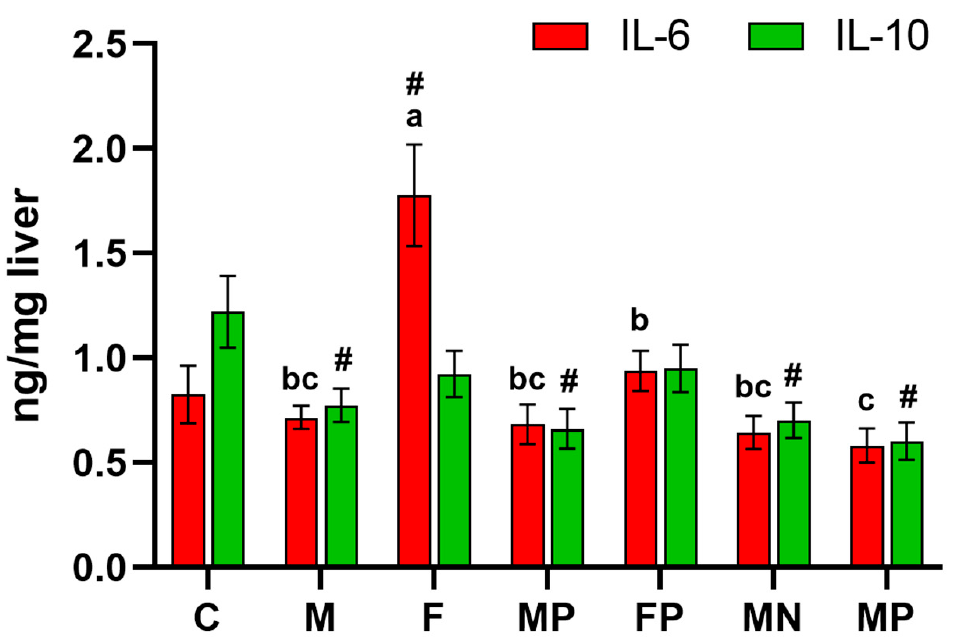
Figure 1. Inflammatory cytokines in the liver of rats fed the experimental diets ( n = 12 per group). a–c Mean values with unlike superscript letters are shown to be significantly different ( p < 0.05) in regard to the experimental groups M, F, MP, FP, MP, MN. Additionally, each experimental group was compared with the control C group using t -test (# indicates a significant difference versus the C group). IL-6, interleukin 6; IL-10, interleukin 10. Table 4. Blood plasma parameters in rats fed experimental diets ( n = 12 per group) Table 3. Hepatic mRNA expression (relative expression normalized to β‐ actin × 10) of selected fac ‐ tors in the liver of rats fed experimental diets ( n = 12 per group) *.